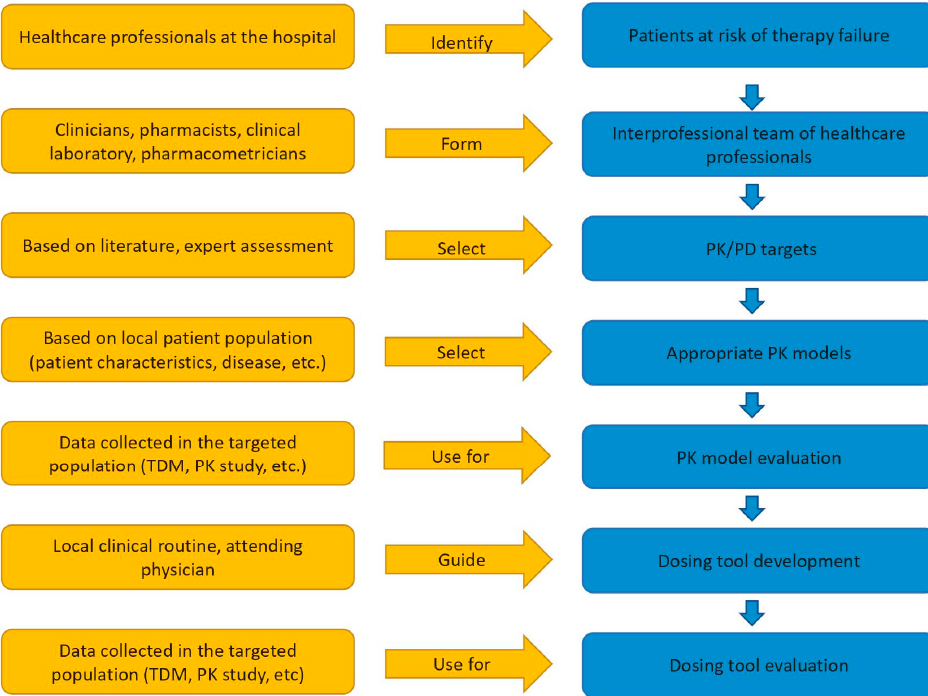
Figure 5. Steps (blue) considered in the generalised workflow development of a tabular precision dosing tool for initial therapy together with recommendations (yellow) to support each step.